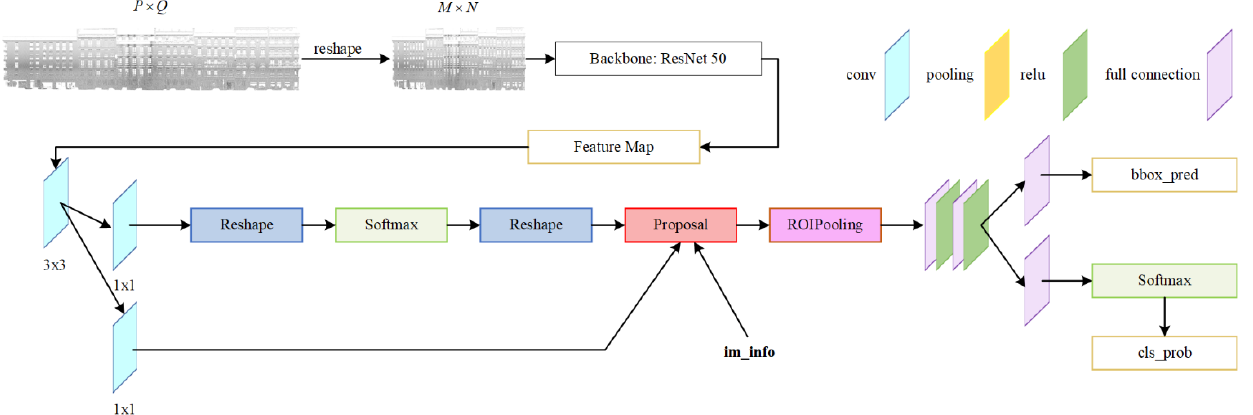
Figure 7. Architecture of Faster R-CNN. The cyan parallelogram, yellow parallelogram, green parallelogram, and purple parallelogram represent the convolutional layer, pooling layer, relu layer, and full connection layer, respectively. P × Q and M × N represent the height and width of the image. “cls_prob” represent the bounding box’s probability of various classes.